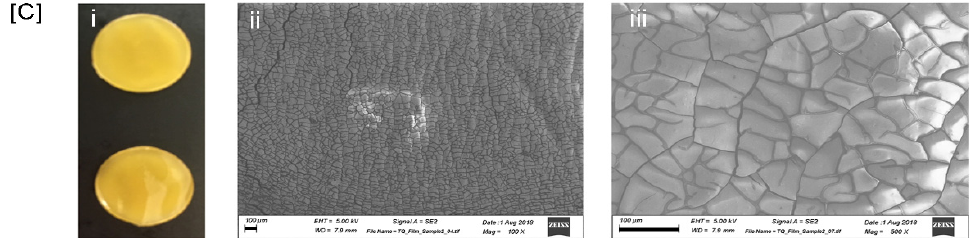
Figure 2. Physicochemical characterization of TQ films. ( A ) FTIR spectrum of TQ pure drug, PVP, physical mixture of drug and polymer, freshly prepared films containing drug and polymer, stored films containing drug and polymer; ( B ) Control films (i), Field emission scanning electron microscopic (FESEM) images showing the surface morphology of control film (ii–iii) at different magnifications (scale bar = 100 µm), and ( C ) TQ films (i), FESEM images showing the surface morphology of TQ films (ii–iii) at different magnifications (scale bar = 100 µm).